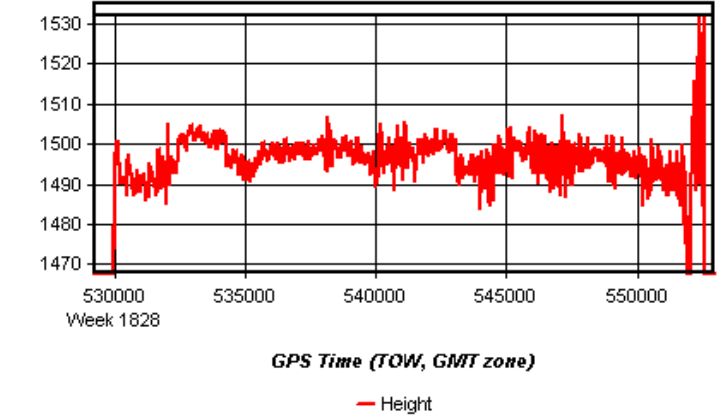
Figure 4. Height profile plot of ground gravimetry. The topographic profile of the measuring line was relatively rough with the peak-to-peak value of about 50 m. Line 1~4 were four repeated lines in this test. There was a data gap around 274,470 and 274,650 s of the week.